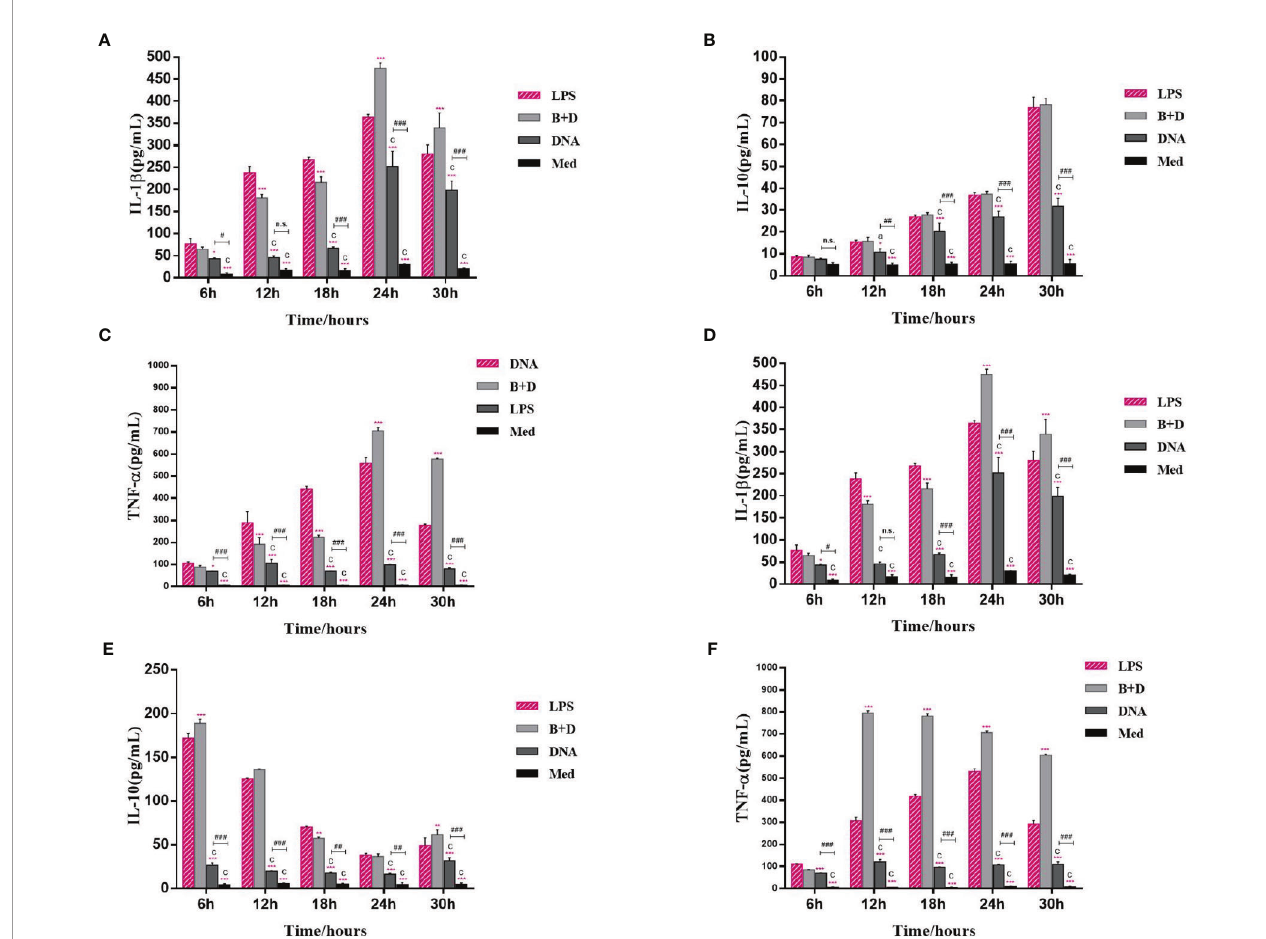
FIGURE 5 | Levels of IL – 1 b , IL – 10, and TNF – a secretion from RAW264.7 cells and peritoneal macrophages. RAW264.7 cells and peritoneal macrophages were incubated with plasmid pCI – PoRV – VP6 (1 mg/mL) and bacterial ghosts (BGs) loaded with pCI – PoRV – VP6 (1000 bacteria/cell), respectively, at 37°C for 2 h. After cultivation for 6, 12, 18, 24 and 30 h, the IL – 1 b , IL – 10, and TNF – a contents in the cell supernatant were detected using ELISA. Levels of (A) IL – 1 b secretion from RAW264.7 cells, (B) IL – 10 secretion from RAW264.7 cells, (C) TNF – a secretion from RAW264.7 cells, (D) IL – 1 b secretion from peritoneal macrophages, (E) IL – 10 secretion from peritoneal macrophages, and (F) TNF – a secretion from peritoneal macrophages. Values are expressed as the mean ± SD of four individual experiments. Signi fi cance of differences between the LPS, BG+DNA, DNA, and Med groups is represented as follows: *P < 0.05, **P < 0.01, ***P < 0.001. Letter indicates signi fi cant differences between BG+DNA, DNA, and Med groups: a P < 0.05, b P < 0.01, c P < 0.001. #Asterisk indicates a signi fi cant difference between DNA and Med groups: # P < 0.05, ## P < 0.01, ### P < 0.001. n.s., no signi fi